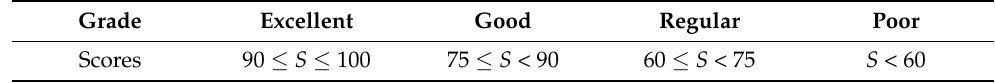
Table 3. Grades of the management capacities of national parks. Grade Excellent Good Regular Poor Scores 90 ≤ S ≤ 100 75 ≤ S < 90 60 ≤ S < 75 S < 60 Source: reference